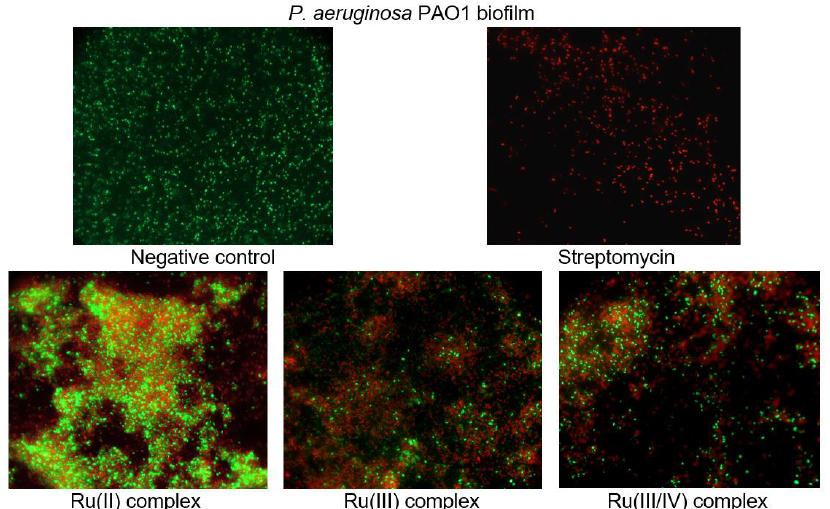
Figure 8. Epifluorescence microscopy images of P. aeruginosa PAO1 biofilm treated with 1 mM of ruthenium complexes. Biofilm was stained with nucleic acid stains using the FilmTracer™ LIVE/DEAD Biofilm Viability Kit (live cells are represented by the color green; dead cells are represented by the color red). The epifluorescence microscopy images were captured at 1000× magnification.